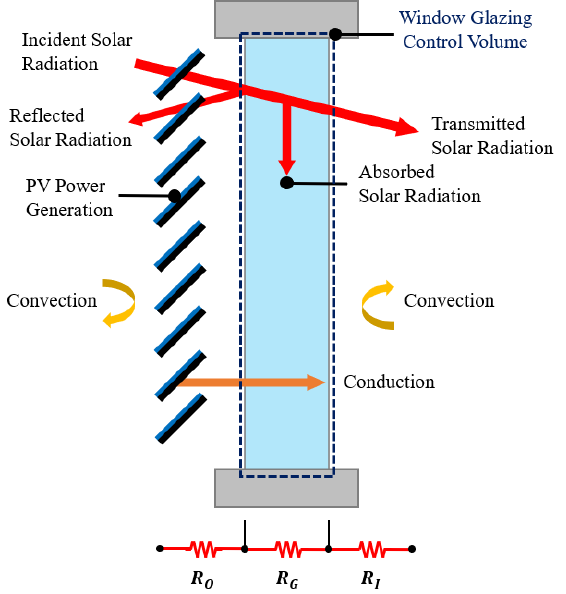
Figure 7. Diagram of the window heat transfer and PV power generation.